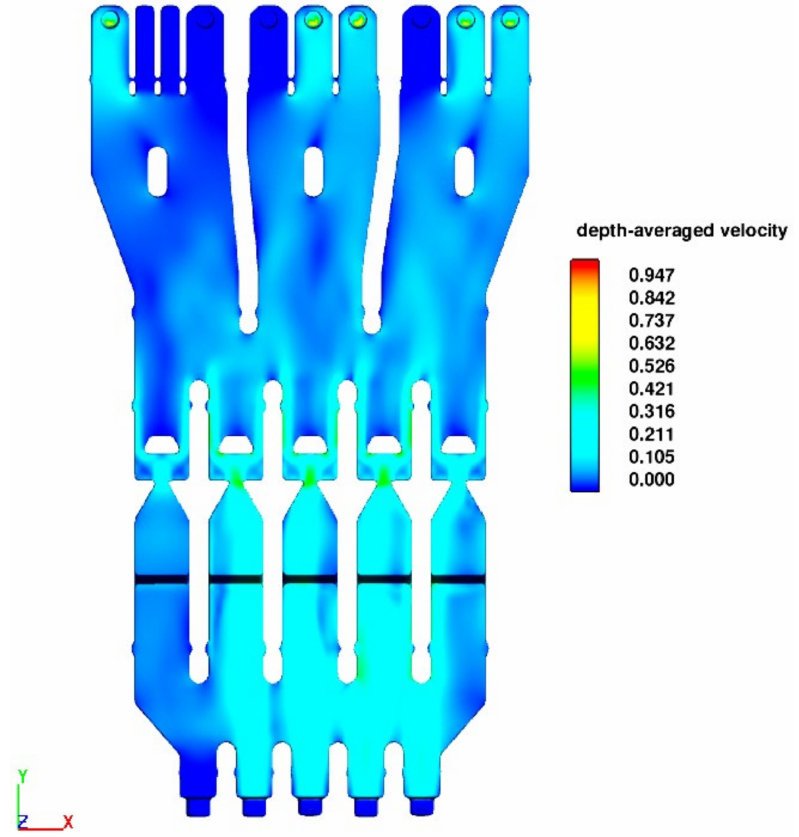
Figure 7. Velocity contours at the basin for scenario II—3D